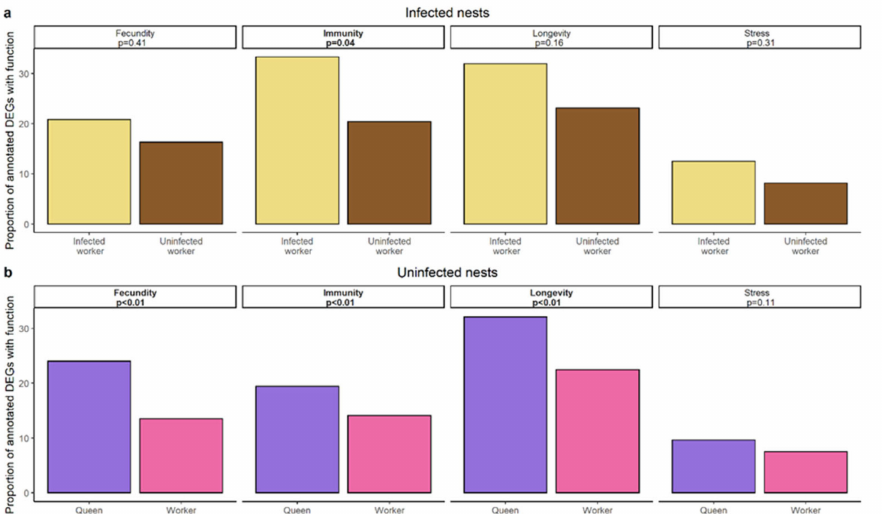
Figure 5. Results of text mining approach of terms related to fecundity, immunity, longevity, and stress based on a UniProt search of upregulated genes in ( a ) infected workers (yellow) and their uninfected nestmates (brown) of infected nests. ( b ) Queens (pink) and workers (purple) of uninfected nests. p -value of χ 2 -test and the according function are given in